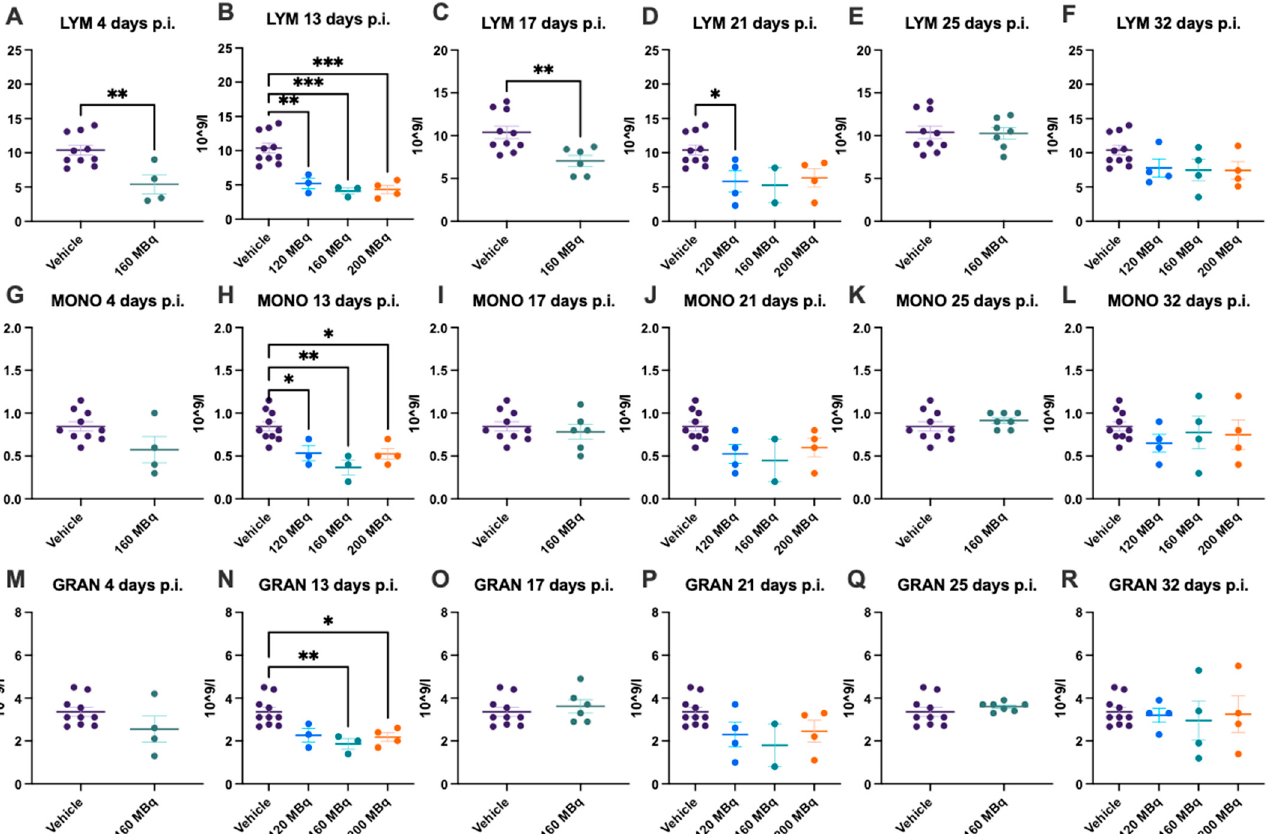
Figure 2. Lymphocyte (LYM) count after 4 ( A ), 13 ( B ), 17 ( C ), 21 ( D ), 25 ( E ), and 32 days ( F ) post injection of 120 MBq ( B , D , F ), 160 MBq ( A – F ), or 200 MBq ( B , D , F ). Monocyte (MONO) count after 4 ( G ), 13 ( H ), 17 ( I ), 21 ( J ), 25 ( K ), and 32 days ( L ) post injection of 120 MBq ( H , J , L ), 160 MBq ( G – L ), or 200 MBq ( H , J , L ). Granulocyte (GRAN) count after 4 ( M ), 13 ( N ), 17 ( O ), 21 ( P ), 25 ( Q ), and 32 days ( R ) post injection of 120 MBq ( N , P , R ), 160 MBq ( M – R ), or 200 MBq ( N , P , R ). Values are presented as individual plots with group mean ± SEM. Differences between groups were an- alyzed using an unpaired t -test ( A , C , E , G , I , K , M , O , Q ) or one-way ANOVA with post-hoc Tukey ( B , D , F , H , J , L , N , P , R ). * p < 0.05, ** p < 0.01, *** p <